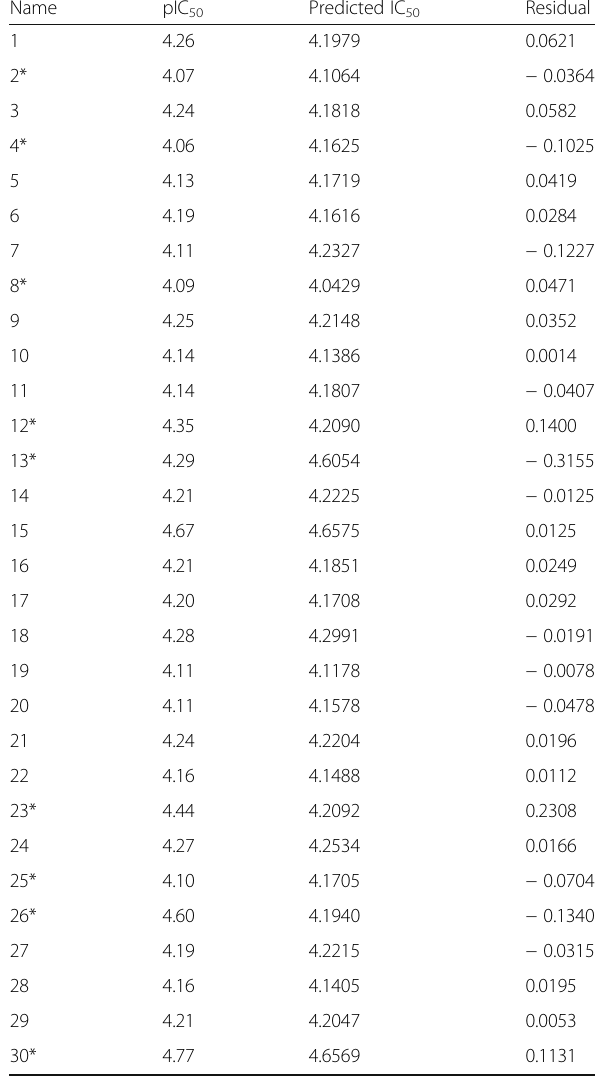
Table 5 Differentiation of bio-activities (pIC 50 ),